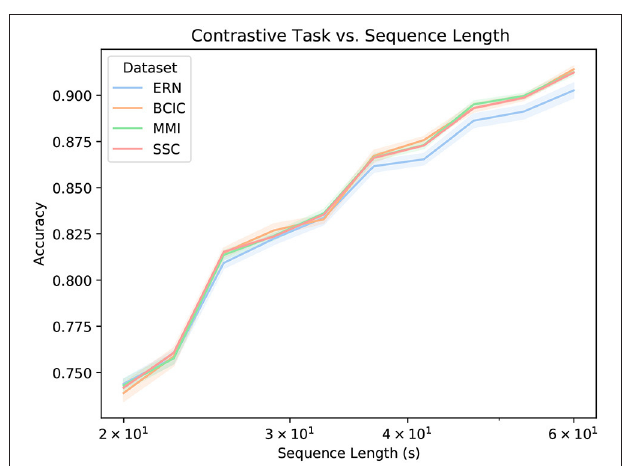
FIGURE 4 | Contrastive accuracy vs. evaluation length in seconds ( x -axis logarithmic). Performance is distinctly similar for all datasets, rising for longer sequences. We suggest that this implies that samples that are further apart are easier to distinguish between than neighboring samples. Thus, while BErt-inspired Neural Data Representations (BENDR) encode local signal characteristics well, there is